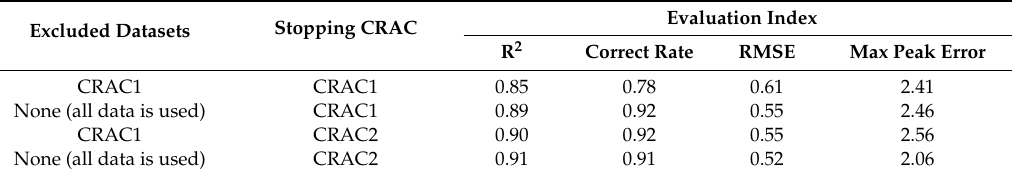
Table 18. Evaluation values when the CRAC1 dataset was excluded from the training data.